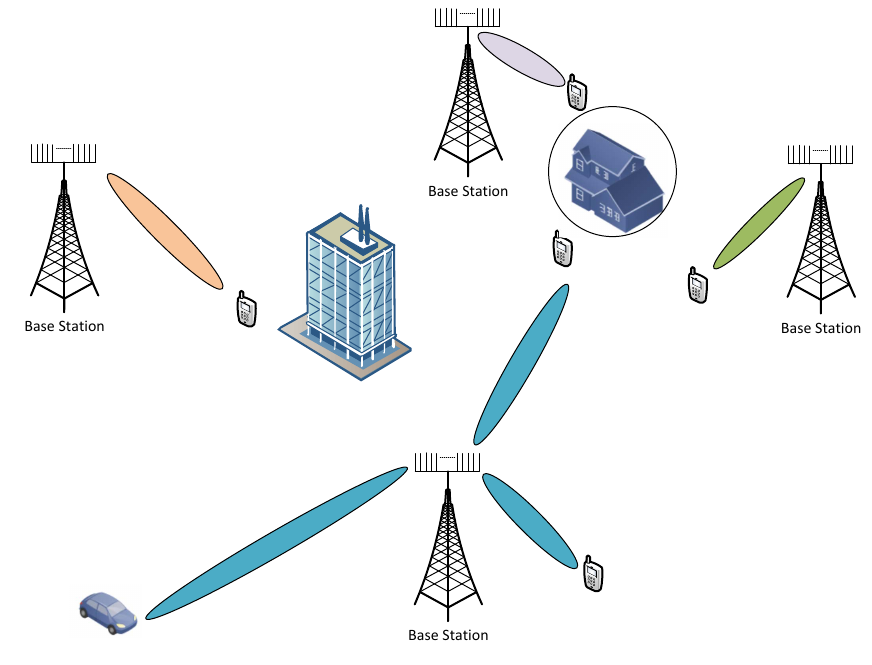
Figure 1. MmWave massive MIMO based cellular